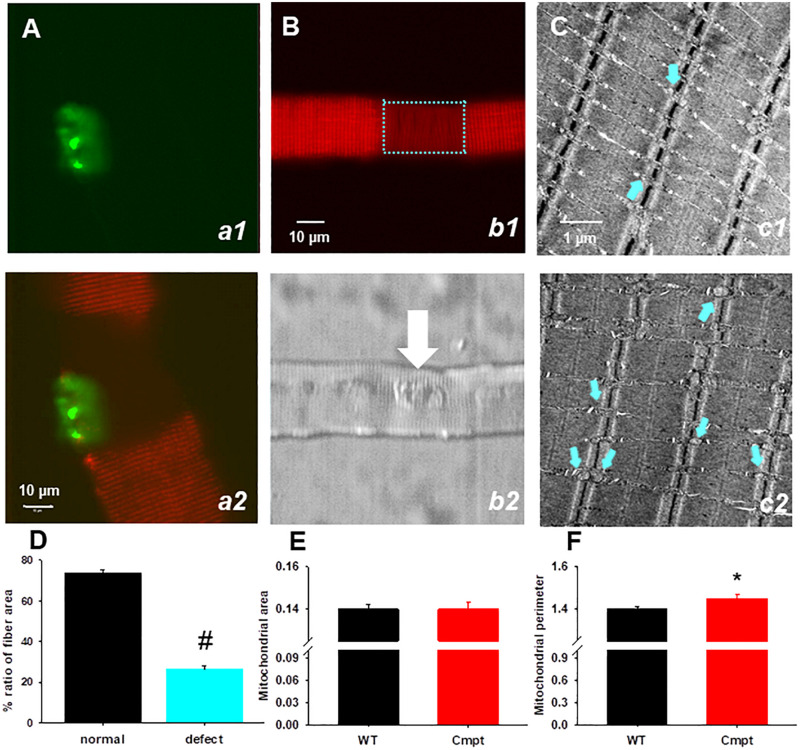
Structural defects of mitochondria in Cmpt fibers. (A) FDB live muscle fiber probed with α-bungarotoxin (panel a1). Overlay of TMRE (red) and α-bungarotoxin images (green) of dually stained FDB fiber (panel a2). Note that the fiber segment with depolarized mitochondria is overlapped with the NMJ area. (B) A segment with depolarized mitochondria is identified in the Cmpt fiber (panel b1 bracket) with TMRE staining. The area of mitochondrial defect had variable sizes, but always faced the NMJ (arrow) as suggested by the transmitted light image (panel b2) (C) Representative electron microscopy images of FDB muscles from 4-month-old WT (panel c1) and Cmpt (panel c2) fibers. In the WT, mitochondria (arrows) aligned within the sarcomeric I band and had uniform sizes. In contrast, Cmpt muscles had enlarged mitochondria (arrows, panel c2). Horizontal field width was 4.9 μm, magnification was 30.000x. (D) Ratio of fiber area displaying mitochondrial defects (n = 28 fiber, N = 4 mice). # denotes significant difference at p < 0.001. (E) Mitochondrial area (E) and perimeter (F) analysis of electron microscopy images similar to those as presented in C revealed no changes in the area but significant increase in perimeter (n = 551 vs. 635, *p < 0.05).